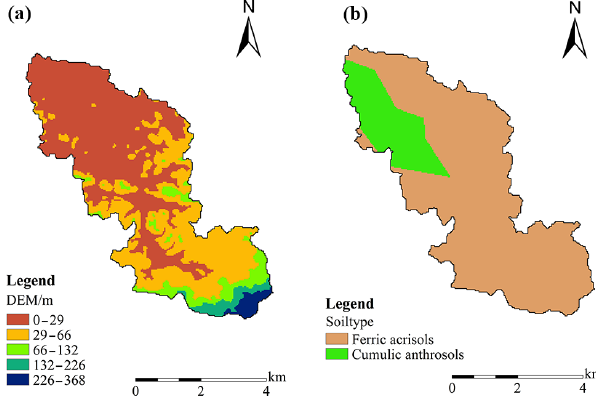
Figure 1. Sketch map of Shigu creek. Figure 2. (a) DEM. (b) Soil type. DEM and soil type of Shigu